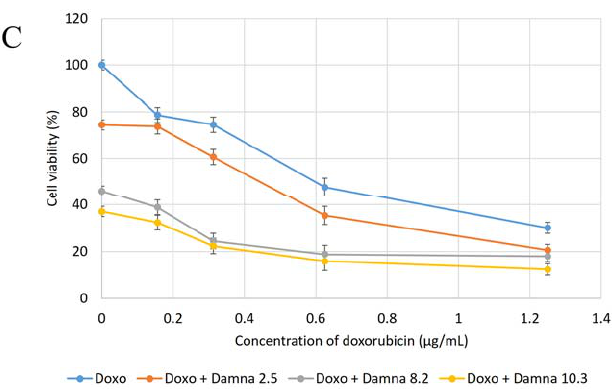
Figure 1. Cytotoxic effects of combination of doxorubicin and damnacanthal on MCF ‐ 7 after ( A ) 24 h, ( B ) 48 h and ( C ) 72 h incubation. Note: doxo: only treated with doxorubicin alone; doxo + damna 2.5: treated with various concentration of doxo in combination with fix dosage of damnacanthal at 2.5 μ g/mL; doxo + damna 8.2: treated with various concentration of doxo in combination with fix dosage of damnacanthal at 8.2 μ g/mL; doxo + damna 10.3: treated with various concentration of doxo in combination with fix dosage of damnacanthal at 10.3 μ g/mL. Error bars represent the standard error of the mean.